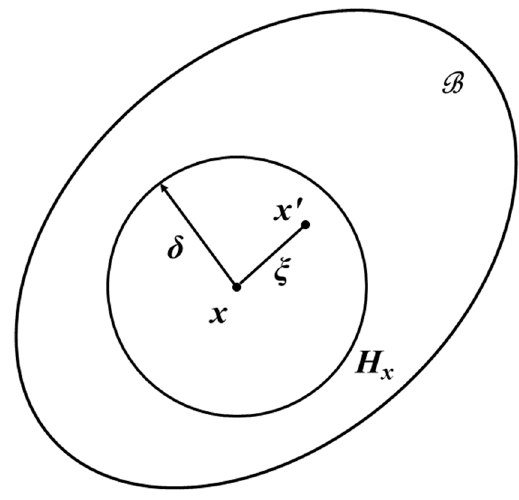
Figure 1. Horizon of material point x .